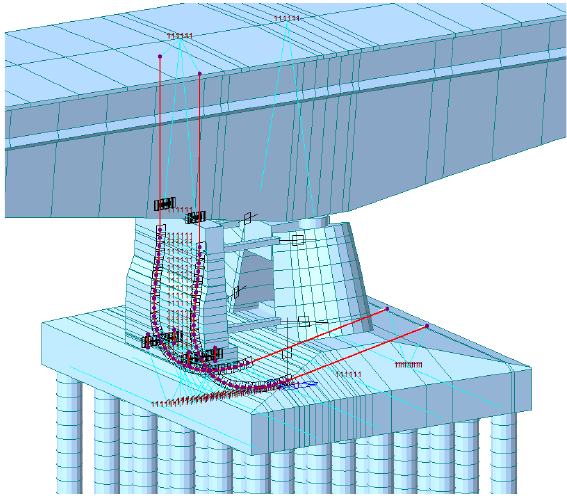
Figure 8. Model of temporary support at